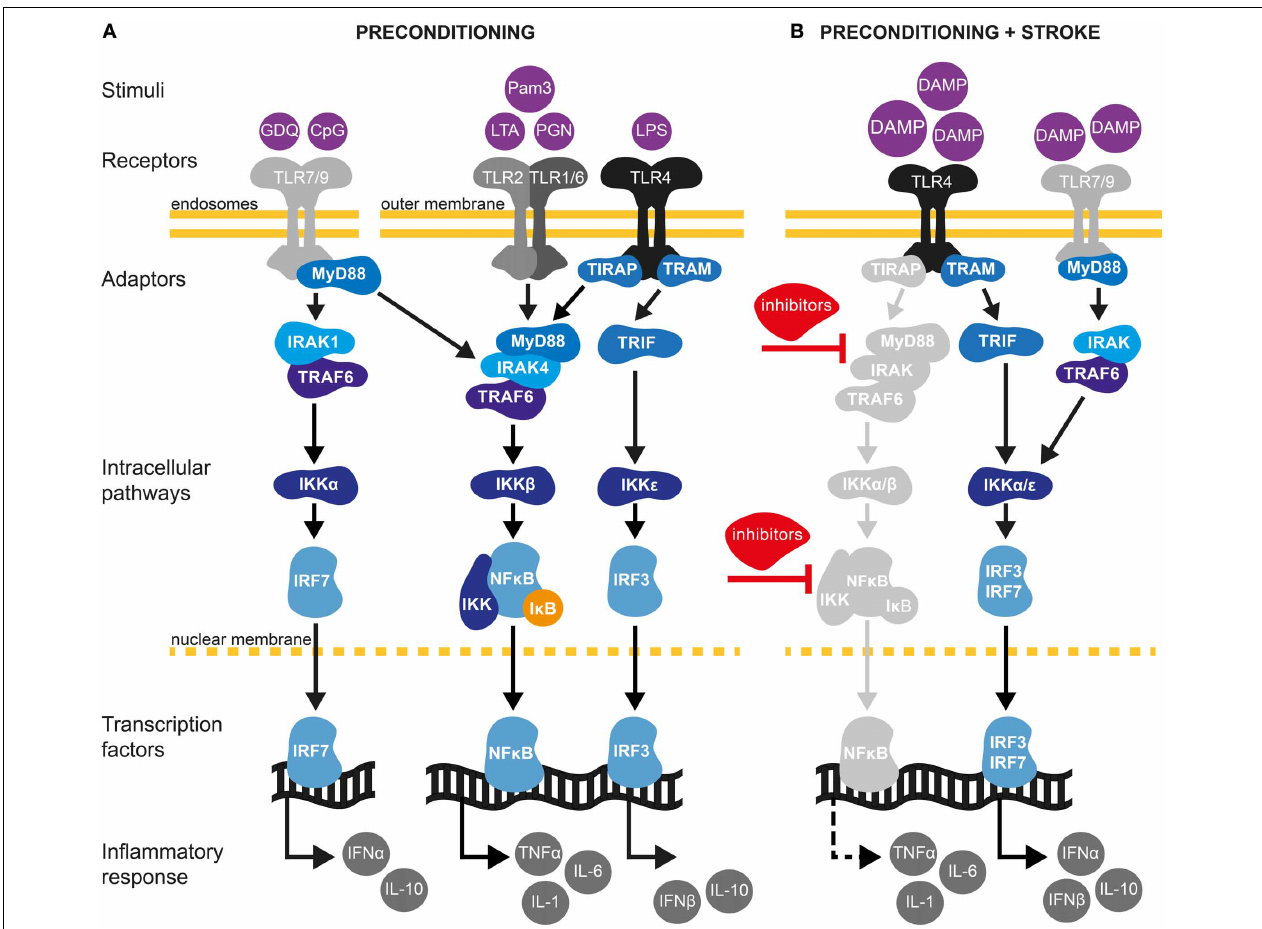
FIGURE 2 | TLR signaling pathways in cerebral IT. (A) Preconditioning through TLRs may be afford by exposure with low dose of pathogen-associated molecular pattern (PAMPs) molecules (Mallard, 2012). TLRs are localized either at the outer cell surface (TLR1, TLR2, TLR4, and TLR6) or within endosomes (TLR7 and TLR9) (Marsh et al., 2009a). TLR2 dimerizes with TLR1 or TLR6 and is activated upon binding of PAMPs such as the synthetic lipopeptide Pam3CysSerLys4 (Pam3CSK4), the non-peptide ligand lipoteichoic acid (LTA) or peptidoglycans (PGN). TLR4 predominantly recognizes lipopolysaccharides (LPS) from Gram-negative bacteria. TLR7 and TRL9 can be activated by the synthetic imidazoquinoline Gardiquimod (GDQ) or small DNA such as non-methylated cytosine-guanosine (CpG), respectively (Wang et